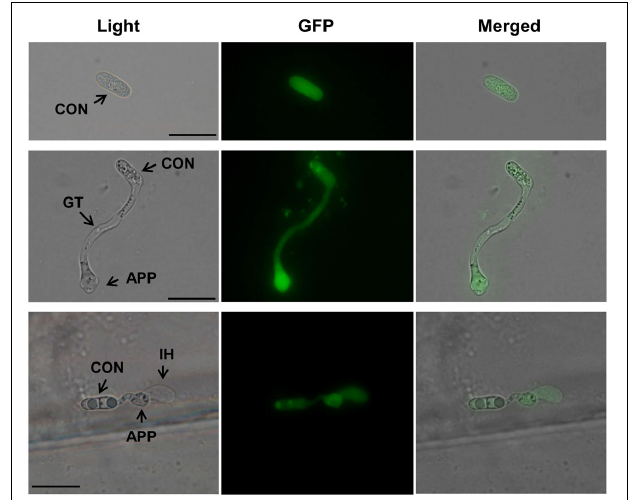
FIGURE 8 | CfPMK1 gene expression during onion epidermis penetration. Scale bar indicates 20 µ m. CON, conidium; APP, appressorium; IH, infectious